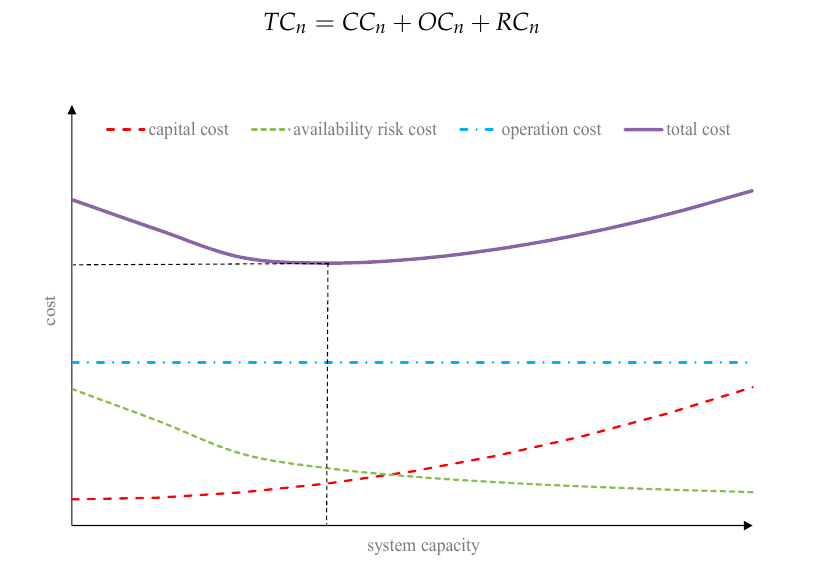
Figure 2. Total cost vs. total cooling capacity.